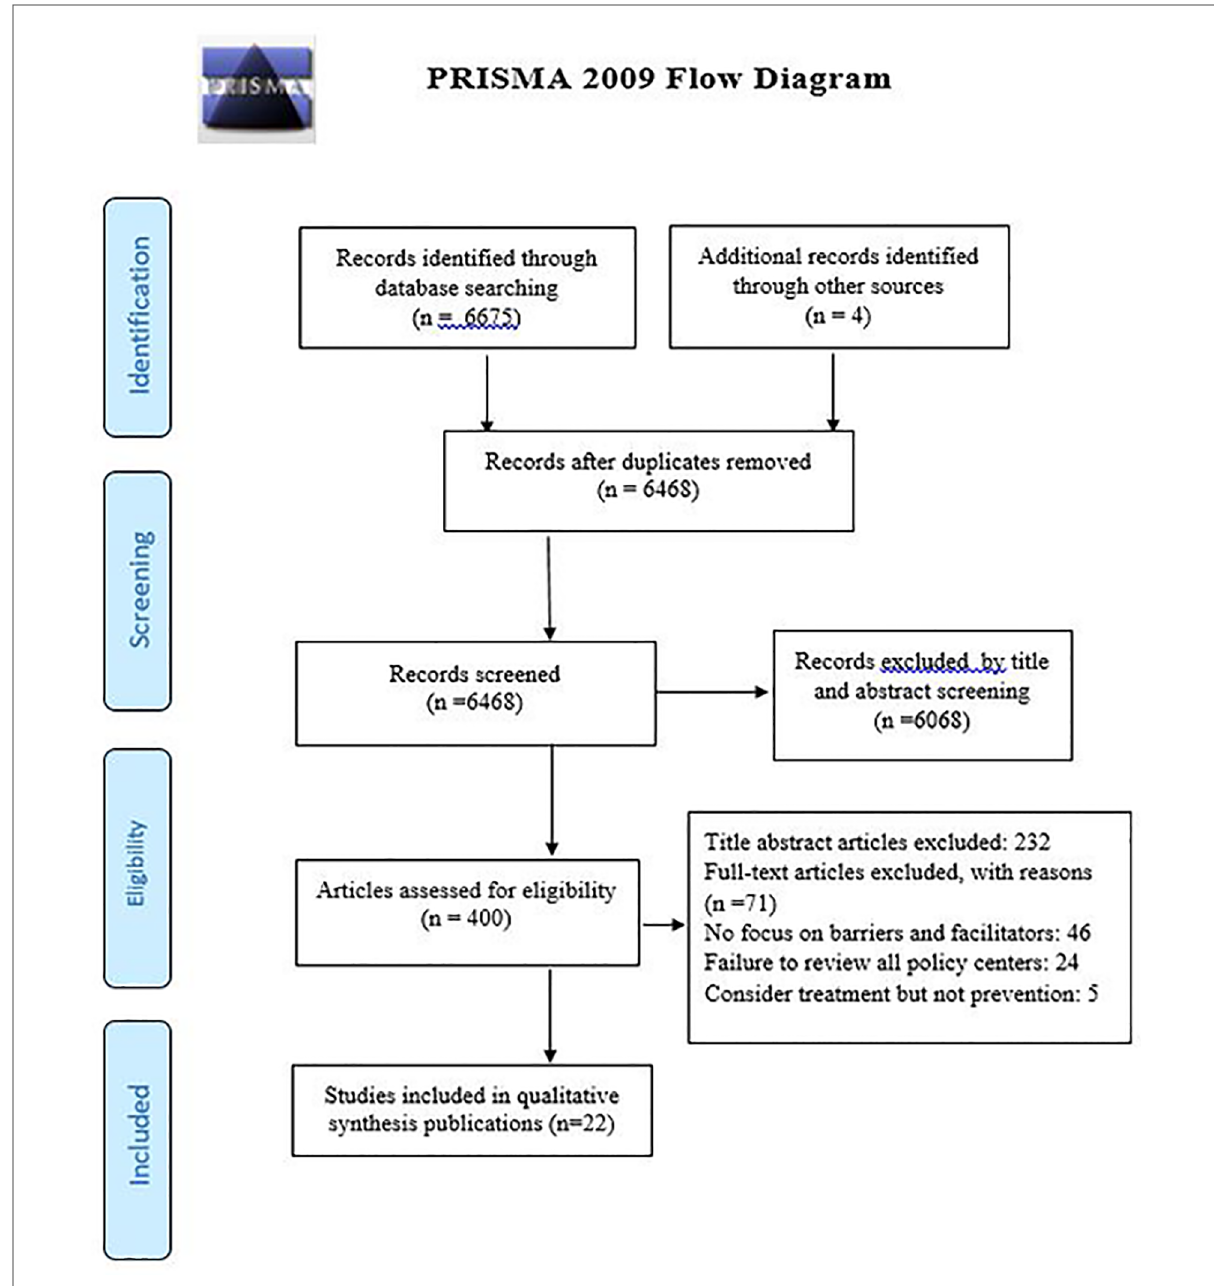
FIGURE 1 Flow chart of study